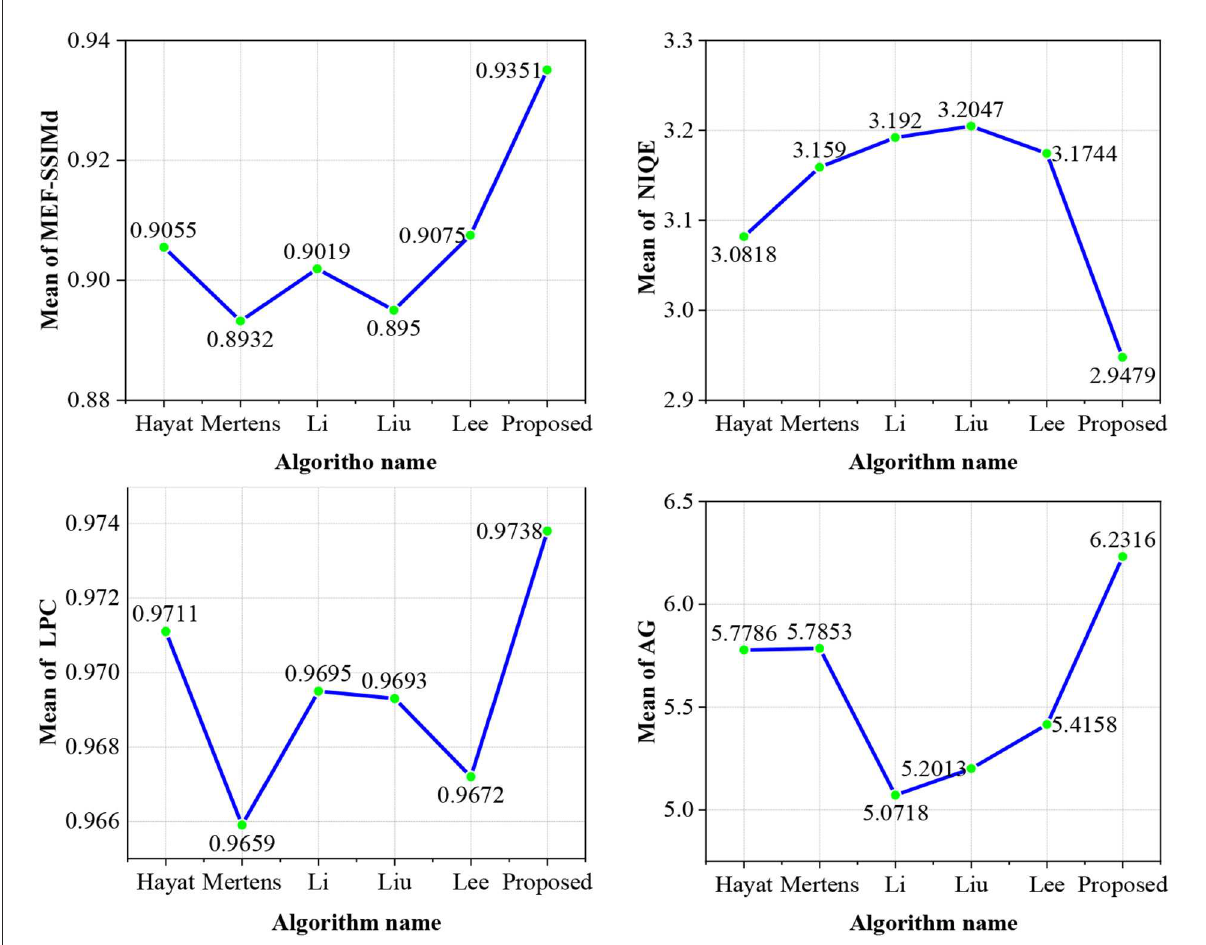
FIGURE12 The mean values of MEF-SSIMd, NIQE, LPC-SI, and AG are obtained by different